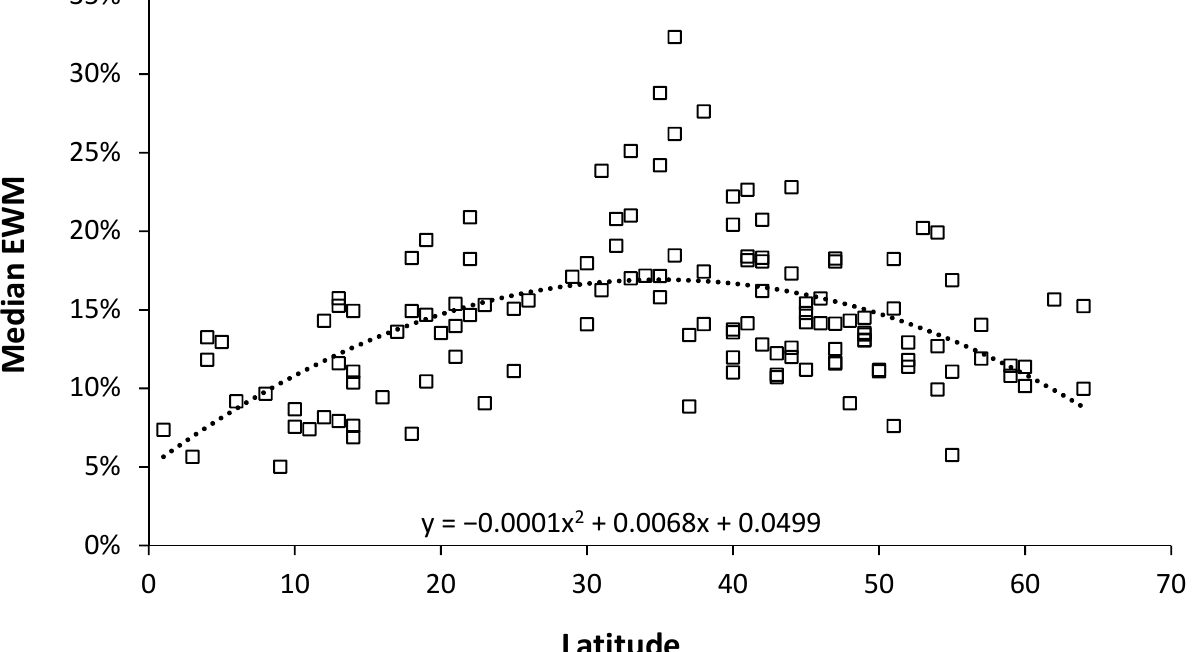
Figure 2. Median value of the EWM for 130 world countries versus latitude. Median for each country ( □ ), do tt ed line second order polynomial line of best fit.